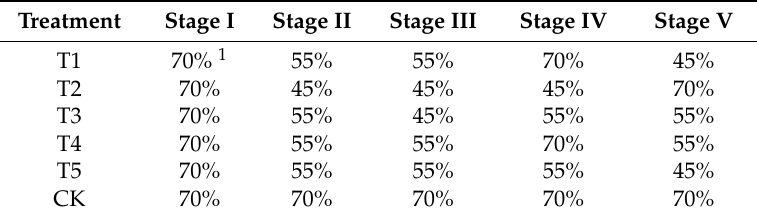
Table 2. Lower limits of soil water content for different irrigation treatments during each winter wheat growth